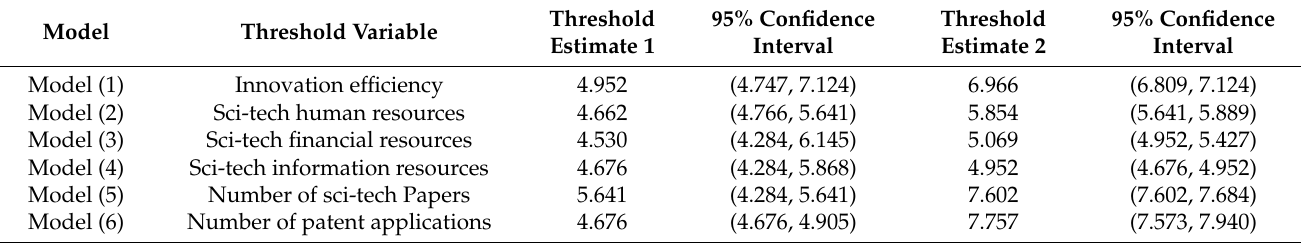
Table 3. Double-threshold estimates.